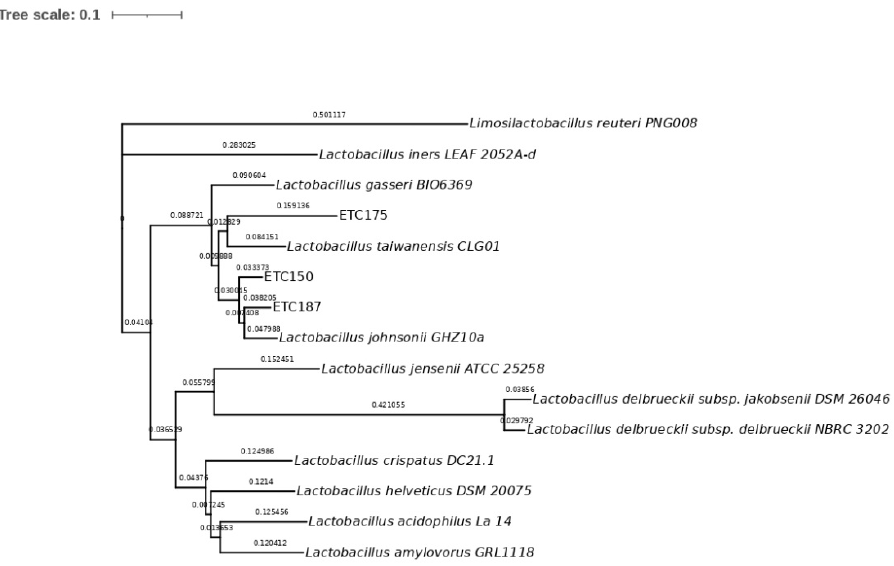
Figure 1. Maximum-likelihood tree with pheS gene sequences. Bar, 10% nucleotide substitutions.